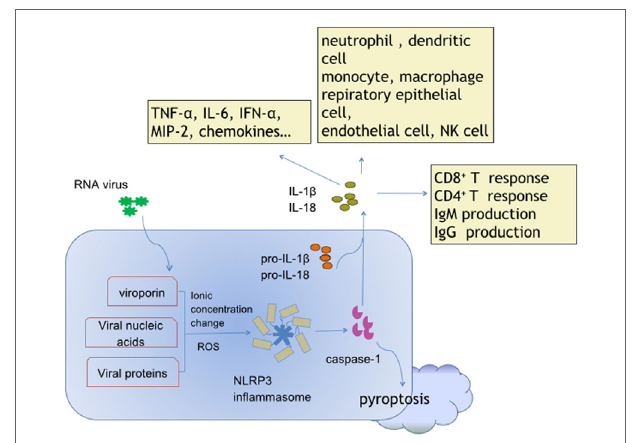
FiGURe 1 | Activation and effects of NACHT, LRR, and PYD domains- containing protein 3 (NLRP3) inflammasome in response to ribonucleic acid (RNA) virus infections. Viroporin, viral nucleic acids, and some virus-encoded functional proteins are able to activate the NLRP3 inflammasome. Viroporin-mediated ion concentration change, virus replication-produced reactive oxygen species, and even viral protein direct binding promote assembly of the NLRP3 inflammasome. The cytokines interleukin (IL)-1 and IL-18 contain extensive downstream effector molecules and effector cells, which ultimately orchestrate innate and adaptive immunity, leading to antiviral defense, and/or inflammatory injury during RNA virus